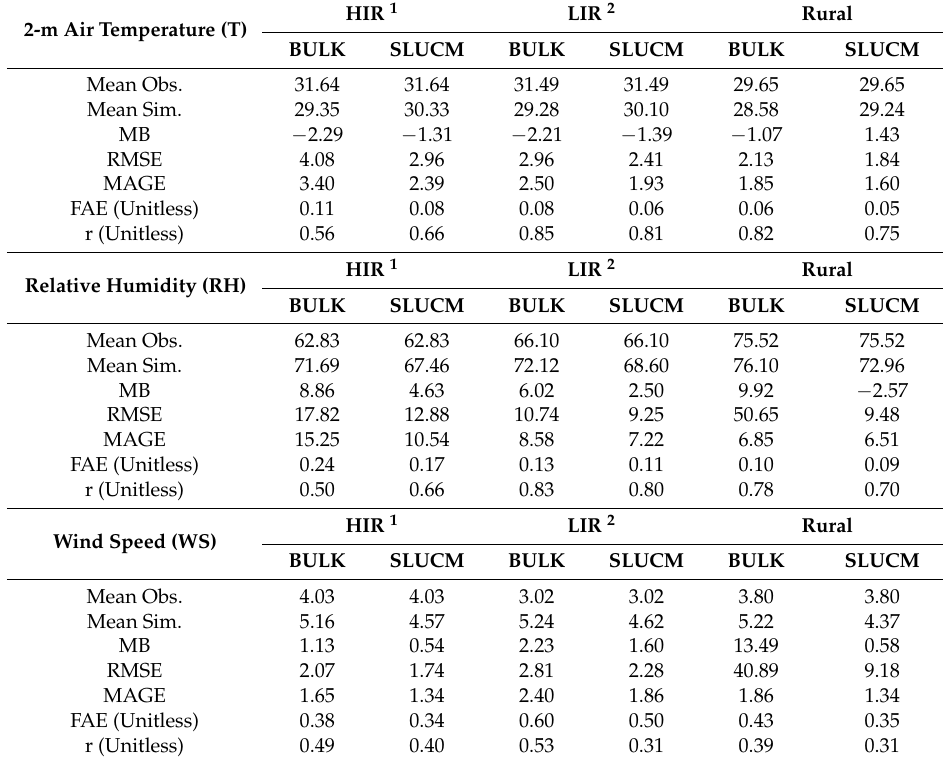
Table 6. Statistical parameters of three different areas between the measured and simulated 2-m air temperature (T), relative humidity (RH), and wind speed (WS) on 1–8 July